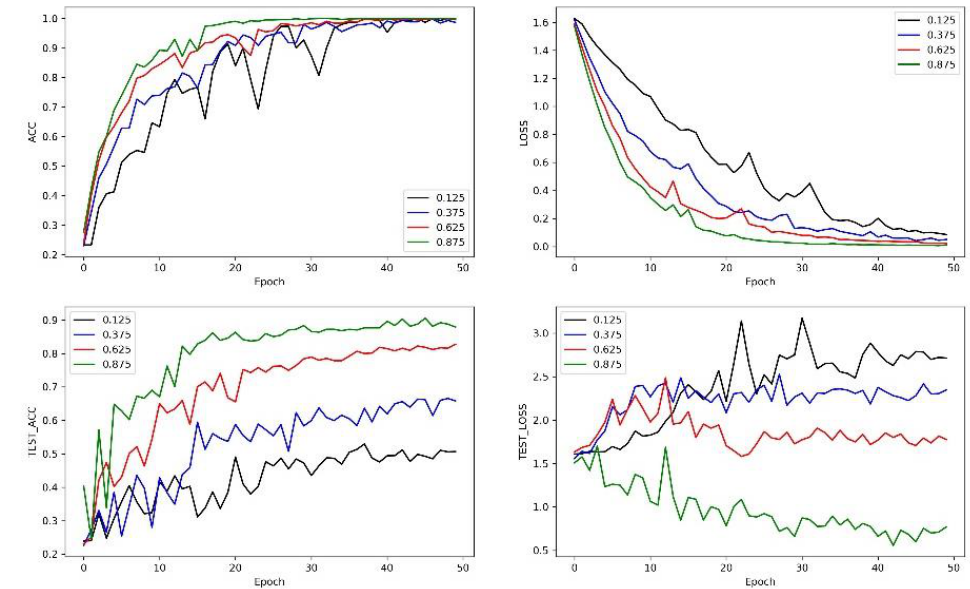
Figure 15. Results of TM1 between different objects.